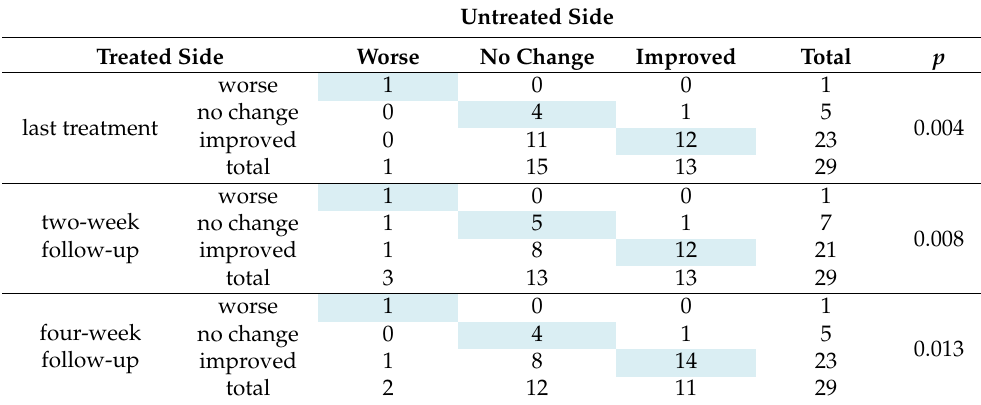
Table 4. Comparison of the Global Aesthetic Improvement Scale between the treated and the untreated side of the face.